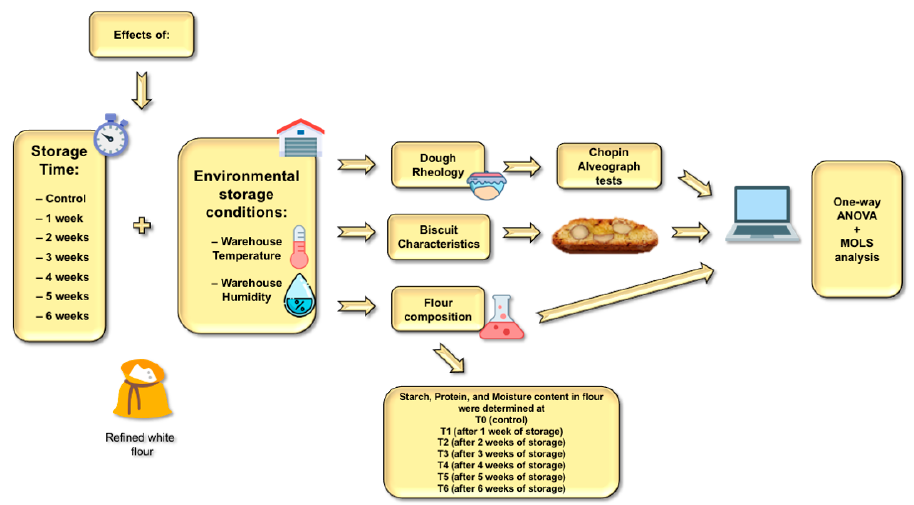
Figure 1. Graphical representation of the